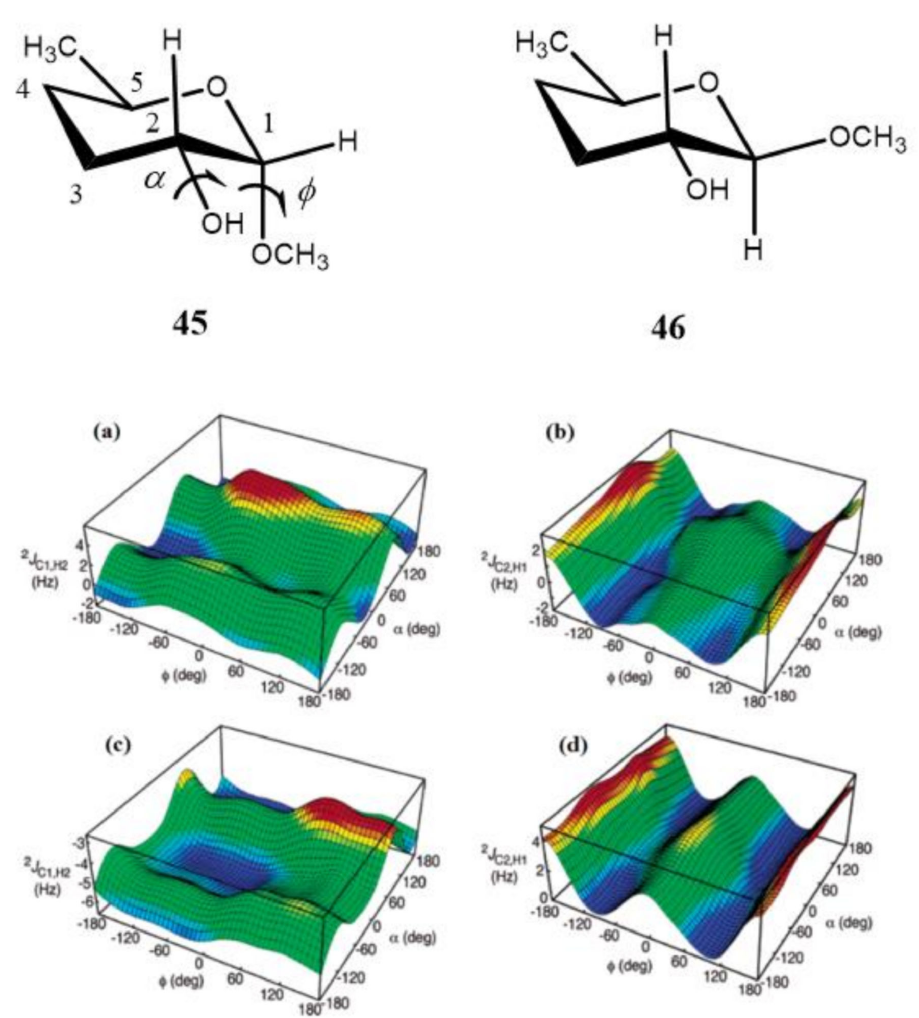
Figure 23. Computed hypersurfaces showing dependencies of geminal carbon-hydrogen couplings on the dihedral angles ϕ and α for: ( a )— 2 J (C-1,H-2) and ( b )— 2 J (C-2,H-1) in compound 45 ; ( c )— 2 J (C-1,H-2) and ( d )— 2 J (C-2,H-1) in compound 46 . Reproduced from Klepach et al. [128] with the permission of the American Chemical